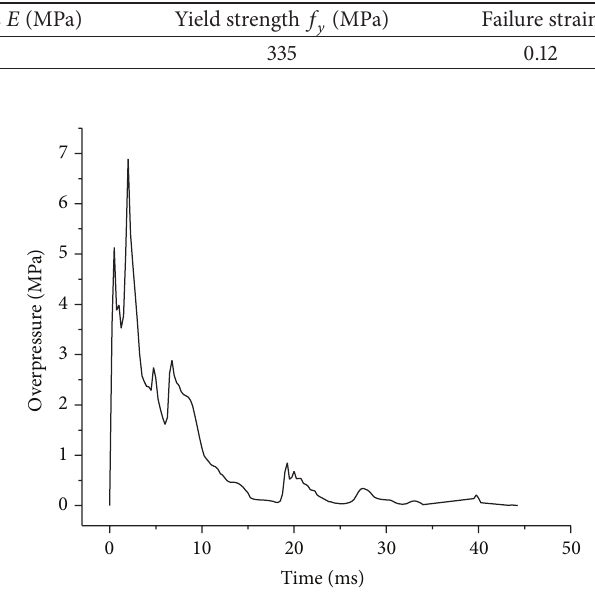
Figure 4: Waveform of TBE explosion in 10 m from blast